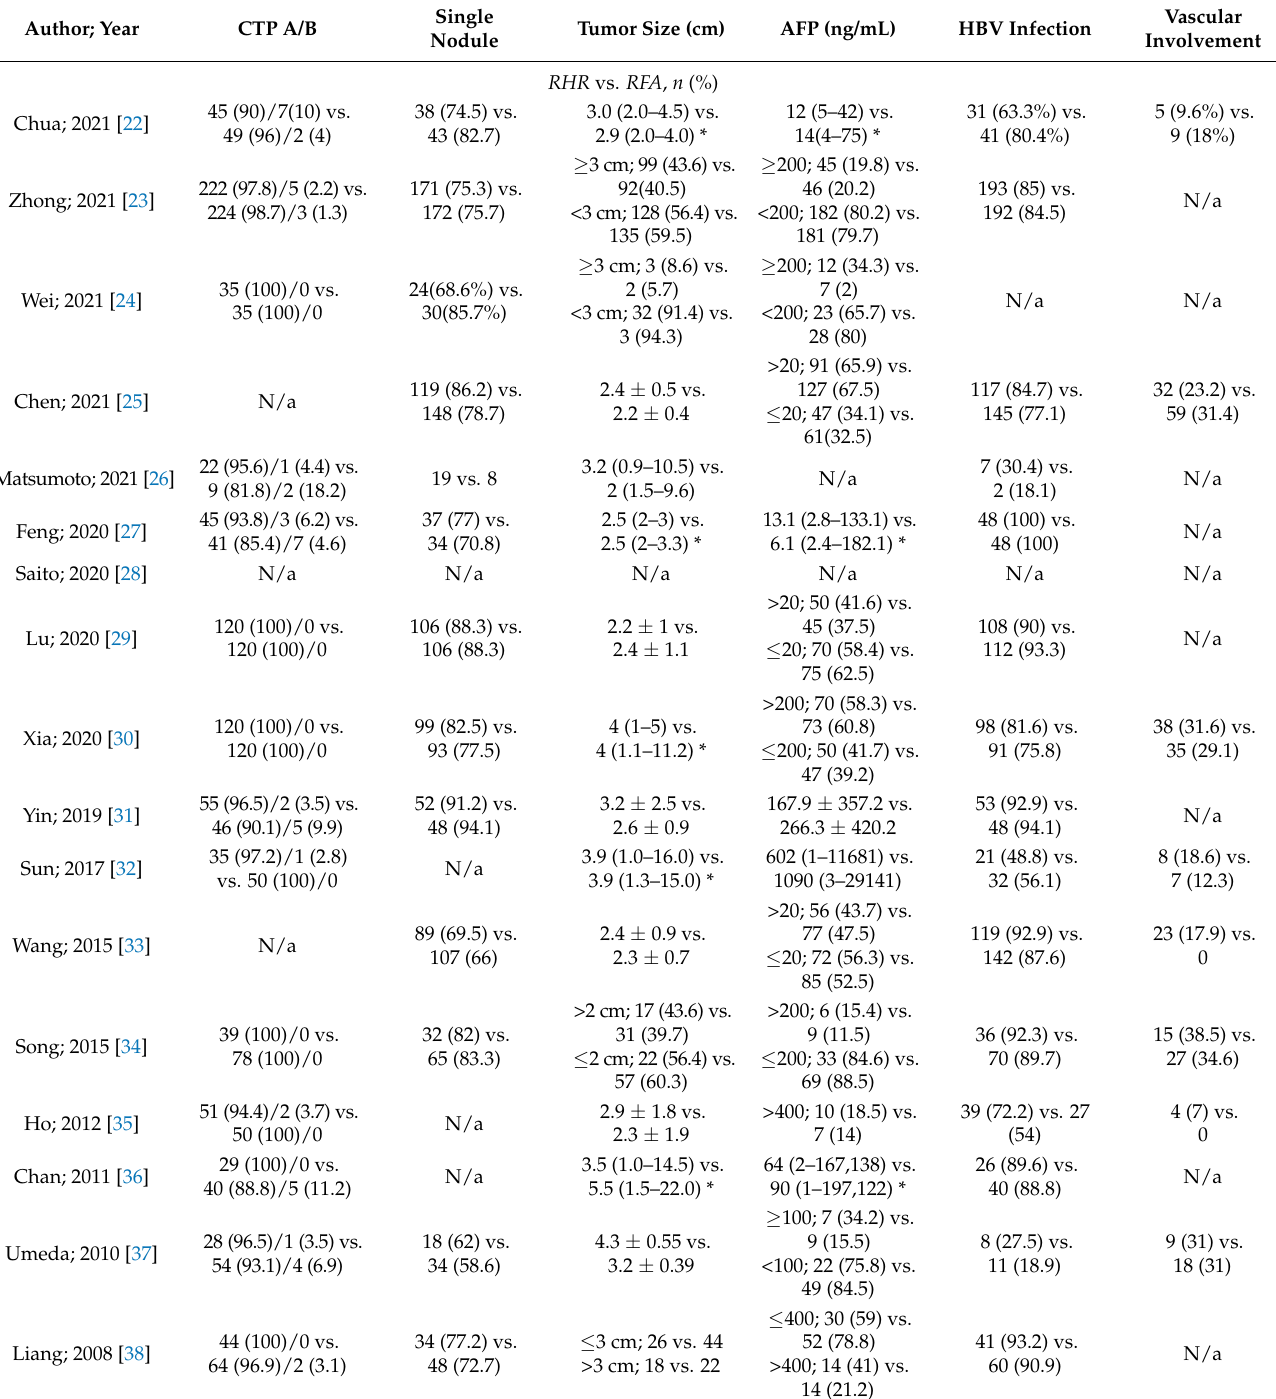
Table 2. Baseline patient characteristics in the included